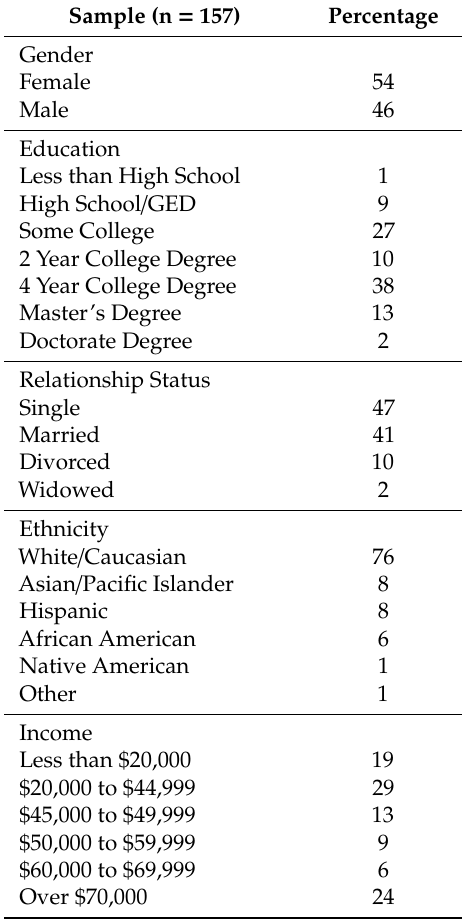
Table 2. Demographic Profile of the